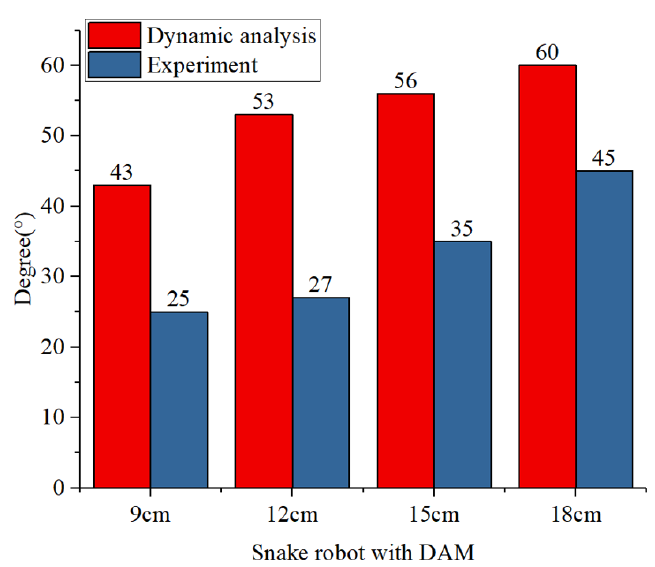
Figure 15. Dynamic modeling values and experiment values in the slope condition.